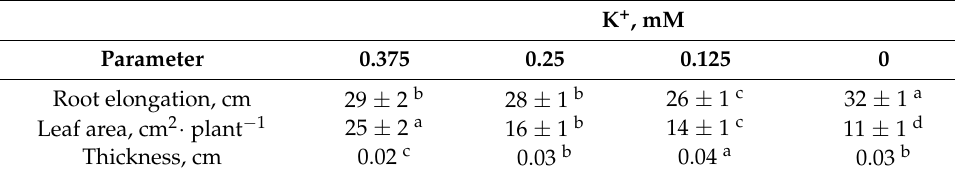
Table 1. Effects of potassium deficiency on root elongation, leaf area and thickness in 64-day-old O. basilicum plants. Measurements carried out after 30 days of treatment in the presence of varying K + concentrations (0.375; 0.25; 0.125 and 0 mM). Means of eight replicates and confidence intervals at the 5% level are presented. Values with the same letters as indicated in the Table are not significantly different according to Duncan’s test at p < 0.05.